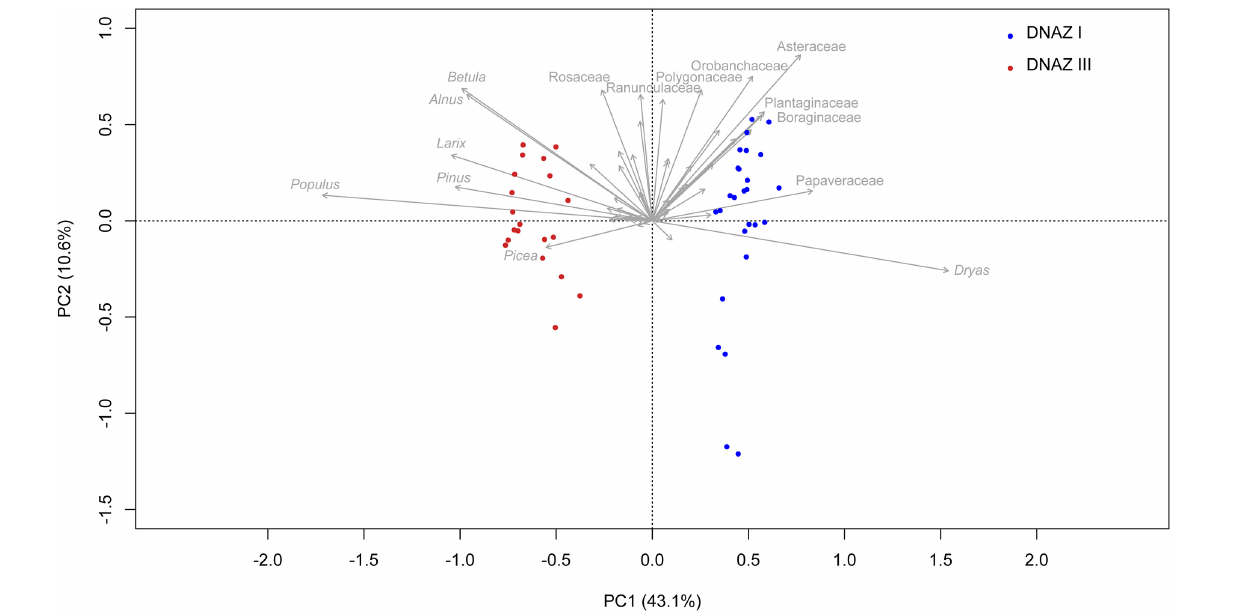
and are mainly represented by Dryas , Asteraceae, Plantaginaceae, Boraginaceae, and Papaveraceae. The samples from DNAZ III are